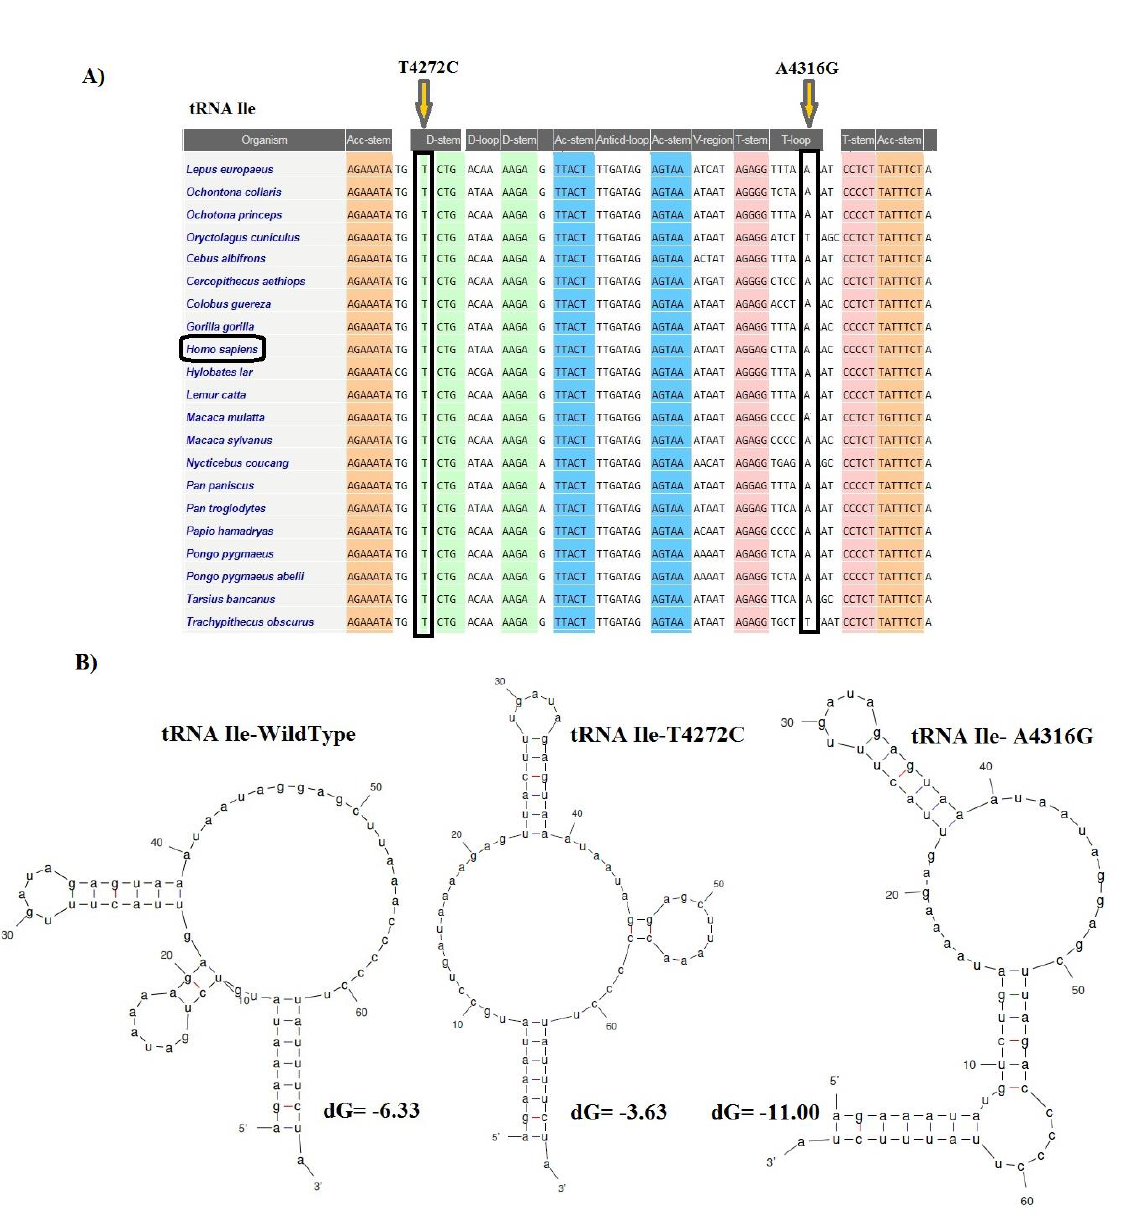
Figure 3: Sequence alignment of tRNA Ile reveals a high-degree of conservation of T4272 and A4316 nucleotides across species. ( A ) The nucleotides T at the position 4272 and A at position 4316 are highly conserved among species. ( B ) Prediction of the structural and folding changes due to T4272C and A4316G nucleotides in tRNA Ile using the Mfold program. The free energy change between the mutant and wild-type states was